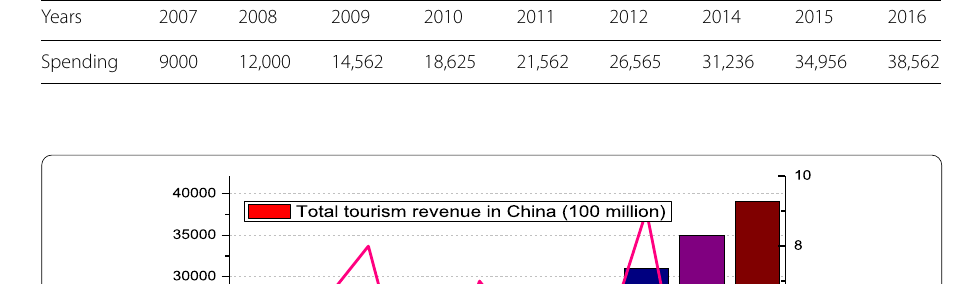
Table 2 Expenditure of tourism in China from 2007 to 2016 (100 million)